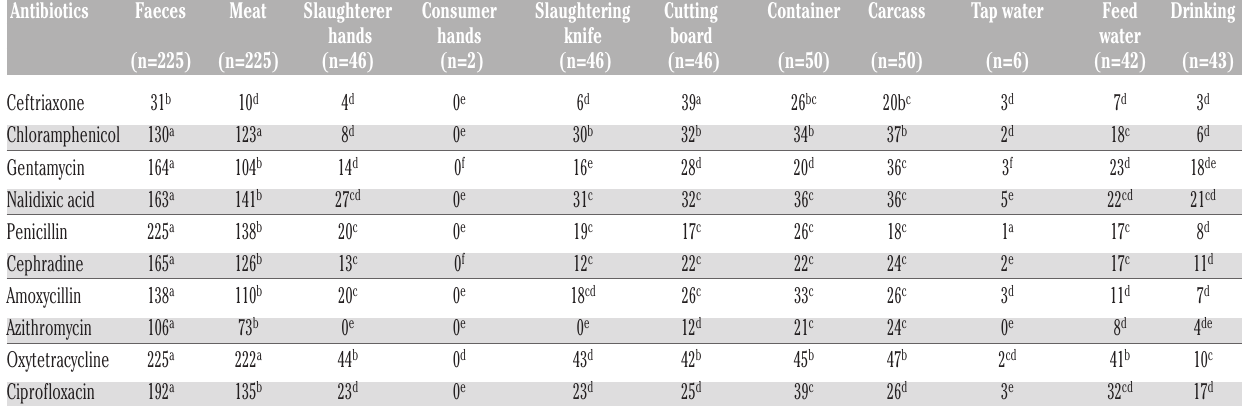
Table 2. Antibiotics resistance in E. coli isolated from different categories of samples taken from poultry shops in Pakistan. Antibiotics